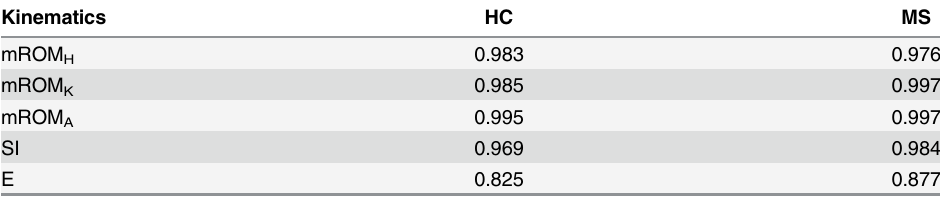
Table 2. Intra-class Correlation Coefficients of Lower Limb